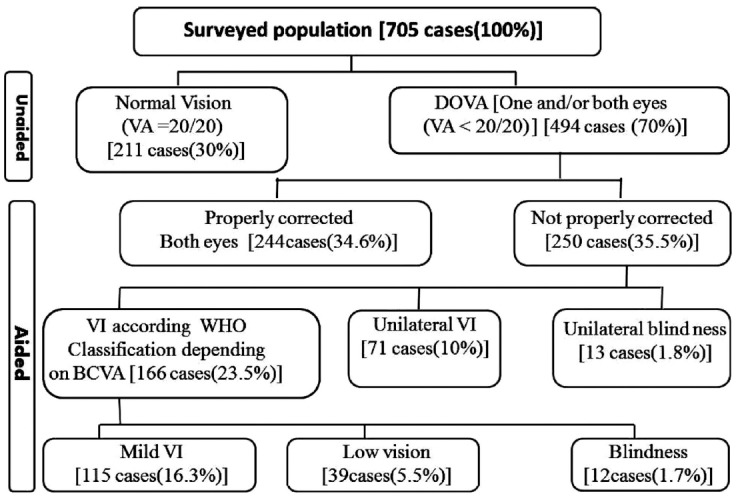
Outcome of the ophthalmic evaluation of the surveyed population.